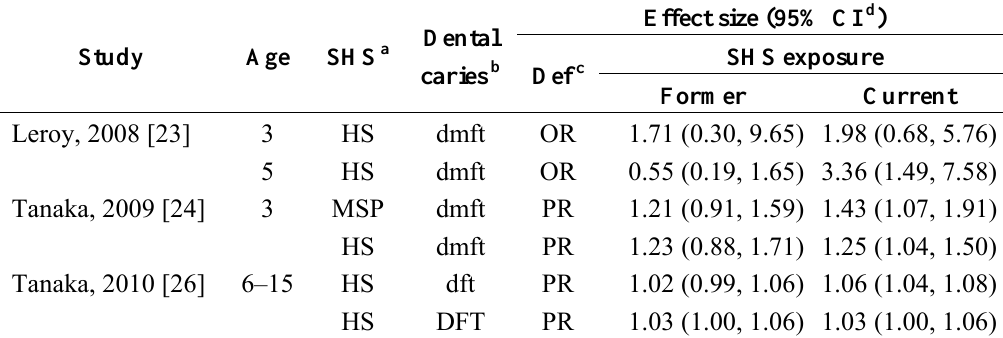
Table 5. Effect of previous exposure to SHS on dental